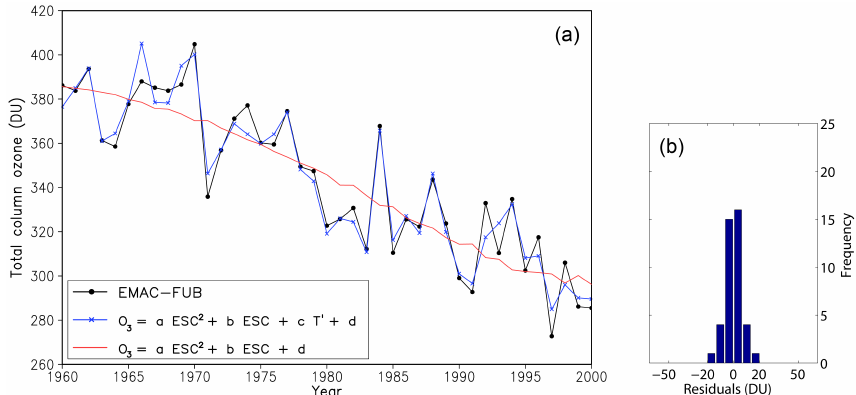
Figure 3. (a) Total column ozone from the EMAC-FUB CCM (black line), from the full regression model (blue line), and from the regression model including the ESC term only (red line). (b) Histogram of the residuals.